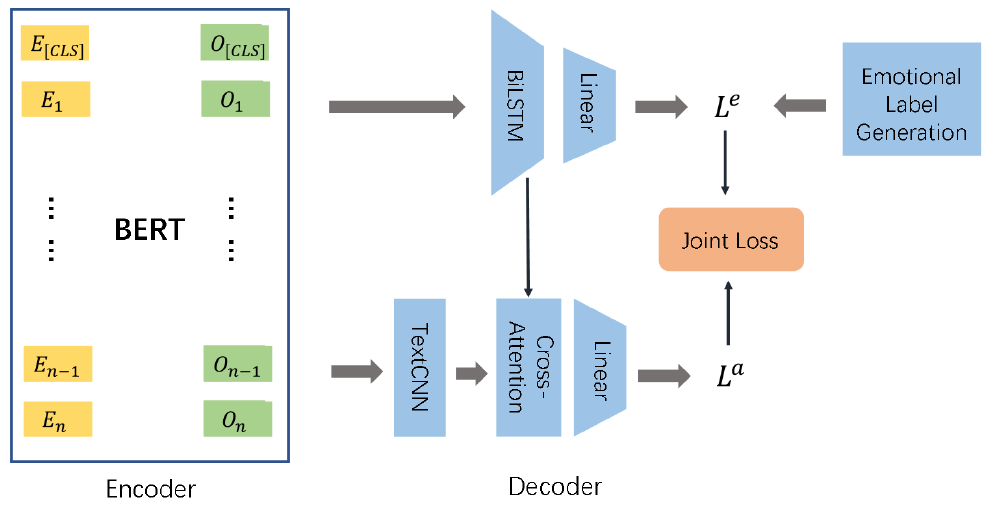
Figure 1. Detailed model structure, which consists of emotional label generation, encoder and decoder. The emotional label generation is a pretrained sentiment analysis model to derive emotion labels. The encoder module encodes the input text and the encoder is initialized with BERT. The decoder module uses TextCNN and BiLSTM for two tasks of abuse detection and emotion classification, and contains a cross-attention interaction mechanism to further improve the effect of abuse